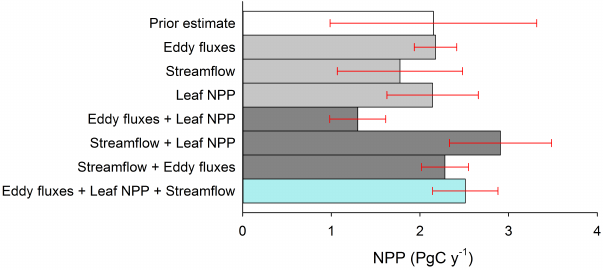
Fig. 4. Mean (1990–2011) Australian continental NPP estimates, obtained using prior parameters and 7 parameter sets obtained by using different observation sets and combinations thereof in the pa- rameter estimation procedure. Error bars represent the 1- σ uncer- tainty attributable to parameter variance and covariance, calculated using Eq.